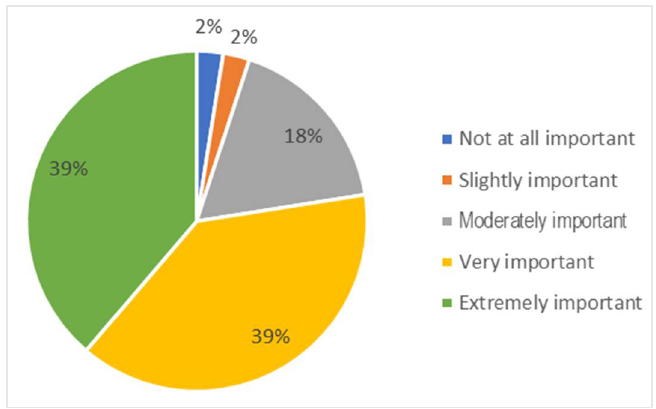
Figure 10. Opinion of respondents on how important they think it is to consider urban biodiversity/habitat provisioning strategies in building design.